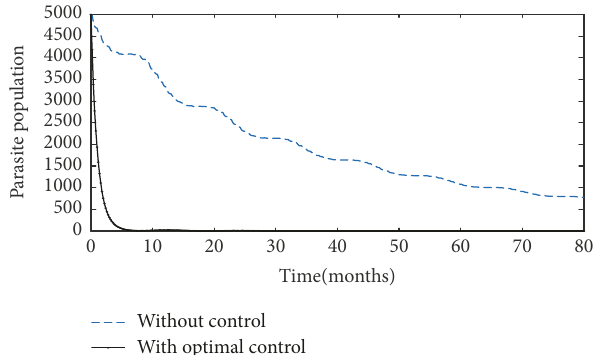
Figure 3: The concentration of the pathogen in the environment with and without the optimal